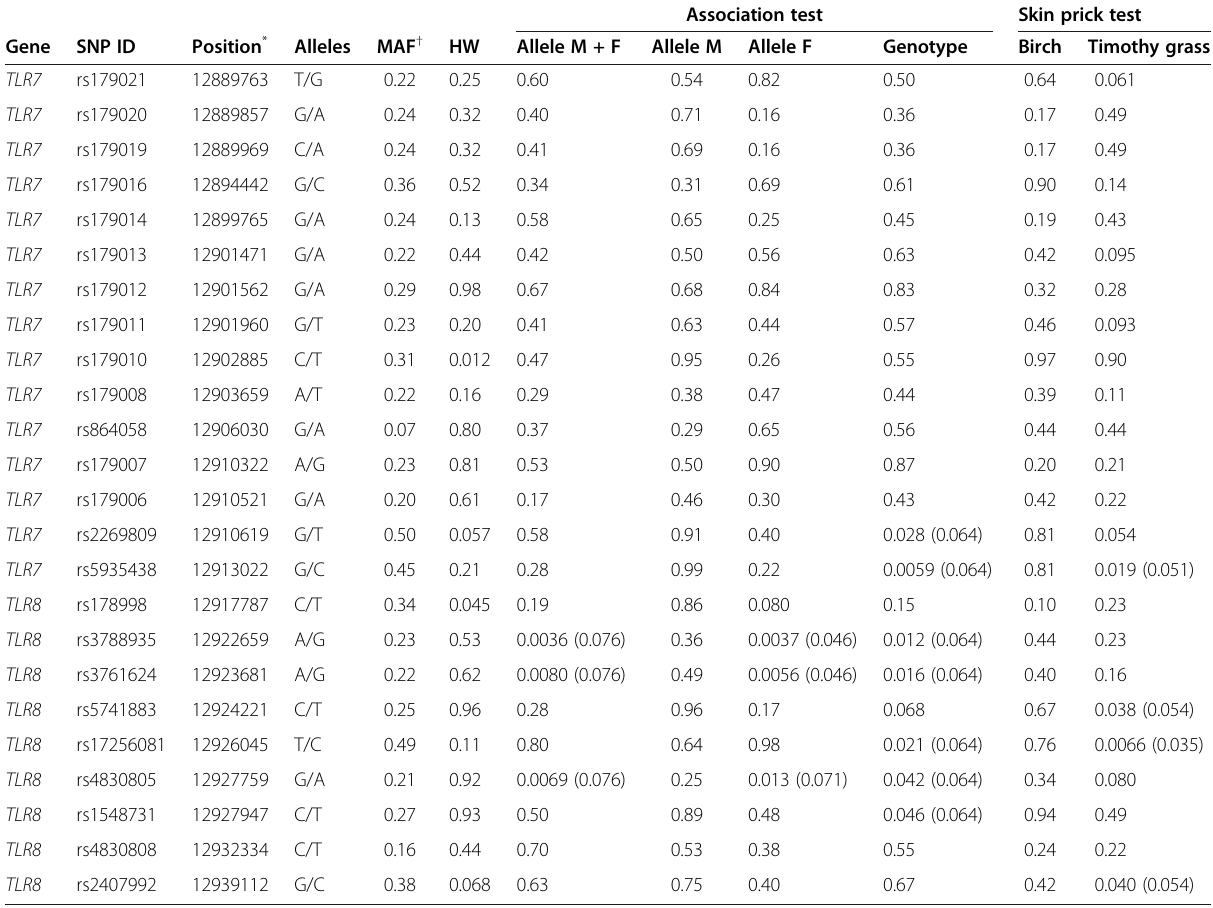
Table 1 Association of SNPs in the TLR7-TLR8 region with AR phenotype in the Swedish population Association test Skin prick test